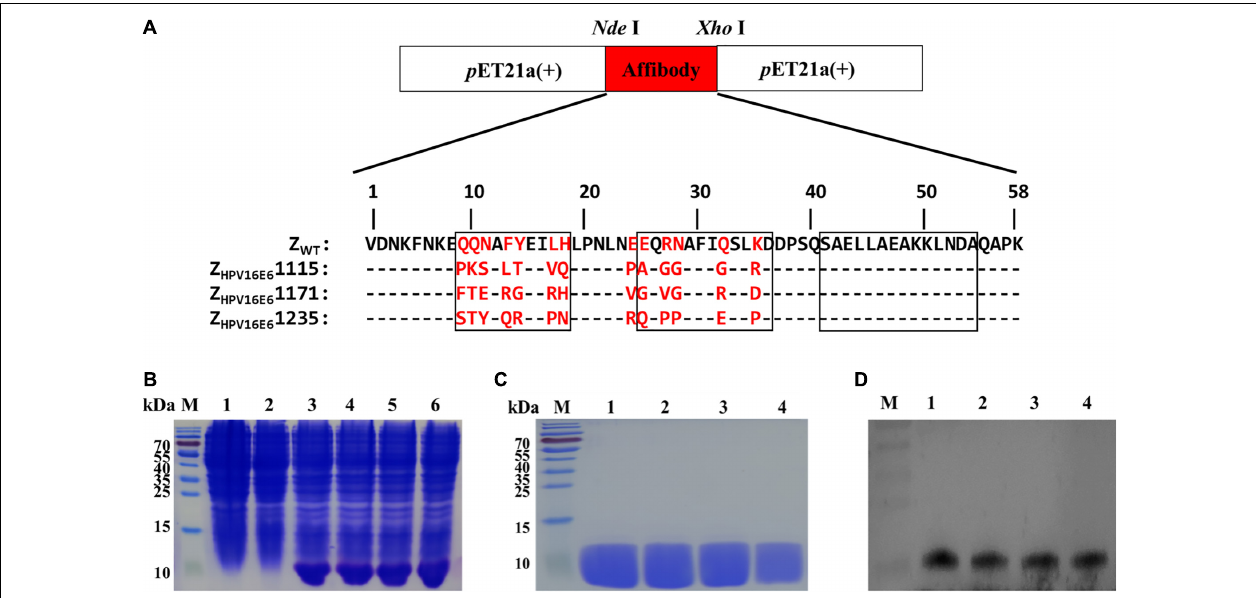
FIGURE 1 | Production of Z HPV16E6 affibodies. (A) The recombinant plasmids of p ET21a(+)/Z HPV16E6 affibodies and p ET21a(+)/Zwt affibody were constructed using the Nde I and Xho I restriction sites and further confirmed by DNA sequencing. Amino acid sequences of the Z WT aligned to 3 selected Z HPV16E6 affibodies. The 13 randomized amino acid positions are highlighted in red. Dashes (–) indicate amino acid identities, and black boxes show three α -helical subdomains in the wild-type Z domain. (B) Coomassie Brilliant Blue-stained SDS-PAGE gel of the recombinant proteins in E. coli BL21 induced by 1 mM IPTG. M, protein ladder; 1, empty E. coli BL21(DE3); 2, E. coli BL21(DE3) transformed with p ET21a(+) empty vector; 3–6, E. coli BL21(DE3) transformed with p ET21a(+)/Z HPV16E6 1115, p ET21a(+)/Z HPV16E6 1171, p ET21a(+)/Z HPV16E6 1235, and p ET21a(+)/Z WT plasmid, respectively. The purified Z HPV16E6 affibodies were evaluated by 15% SDS-PAGE (C) and verified by Western blotting (D) M, protein marker; 1, Z HPV16E6 1115; 2, Z HPV16E6 1171; 3, Z HPV16E6 1235; and 4, Z WT .